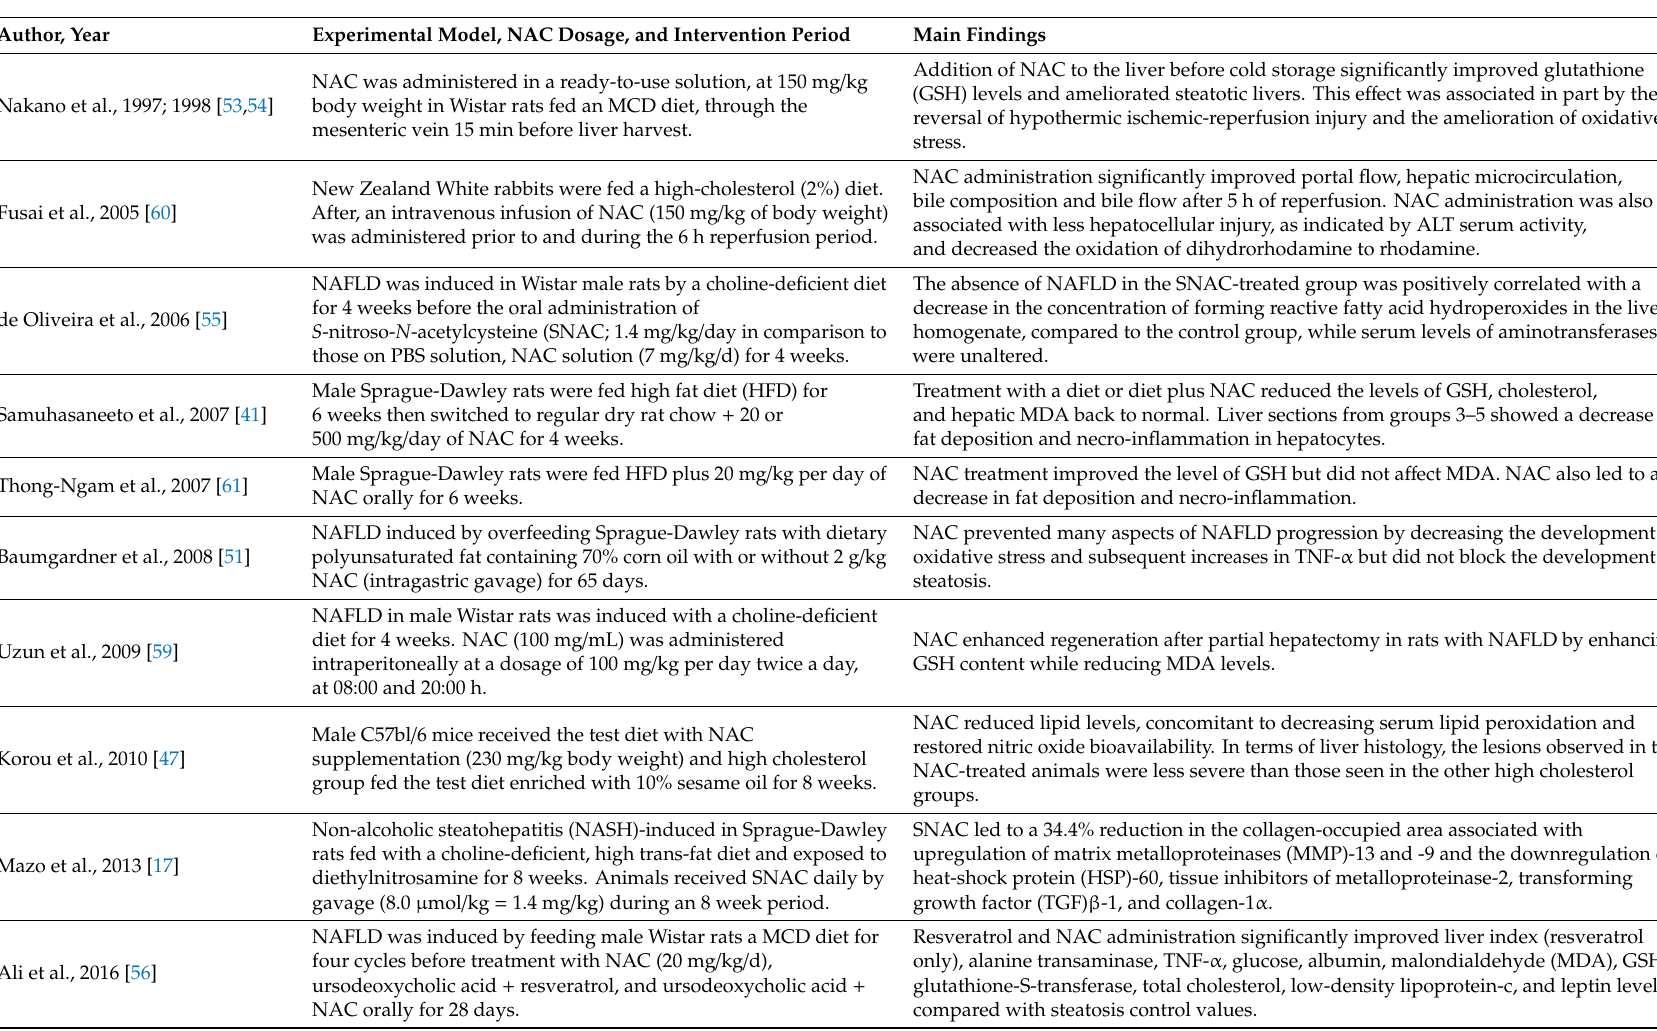
Table 2. An overview of studies on the impact of N-acetyl cysteine (NAC) on oxidative stress and inflammation in preclinical models of